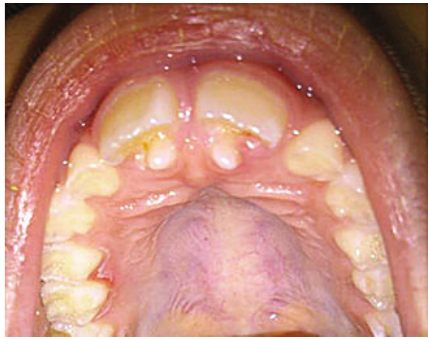
Figure 1: Anomalous projection elements in the region of 11: 21. Figure 2: Cusp talon 6 mm in height with a probing depth of 1- 2 mm.